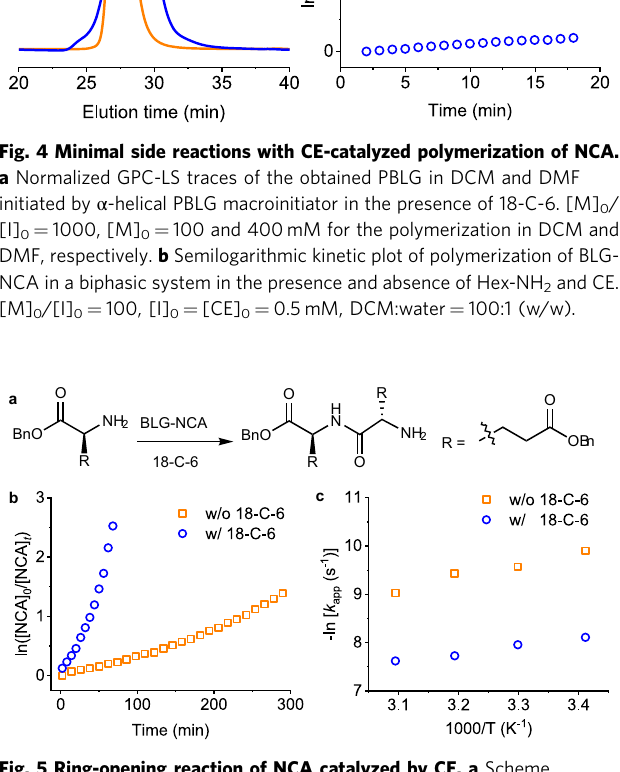
NATURE COMMUNICATIONS| (2021) 12:732